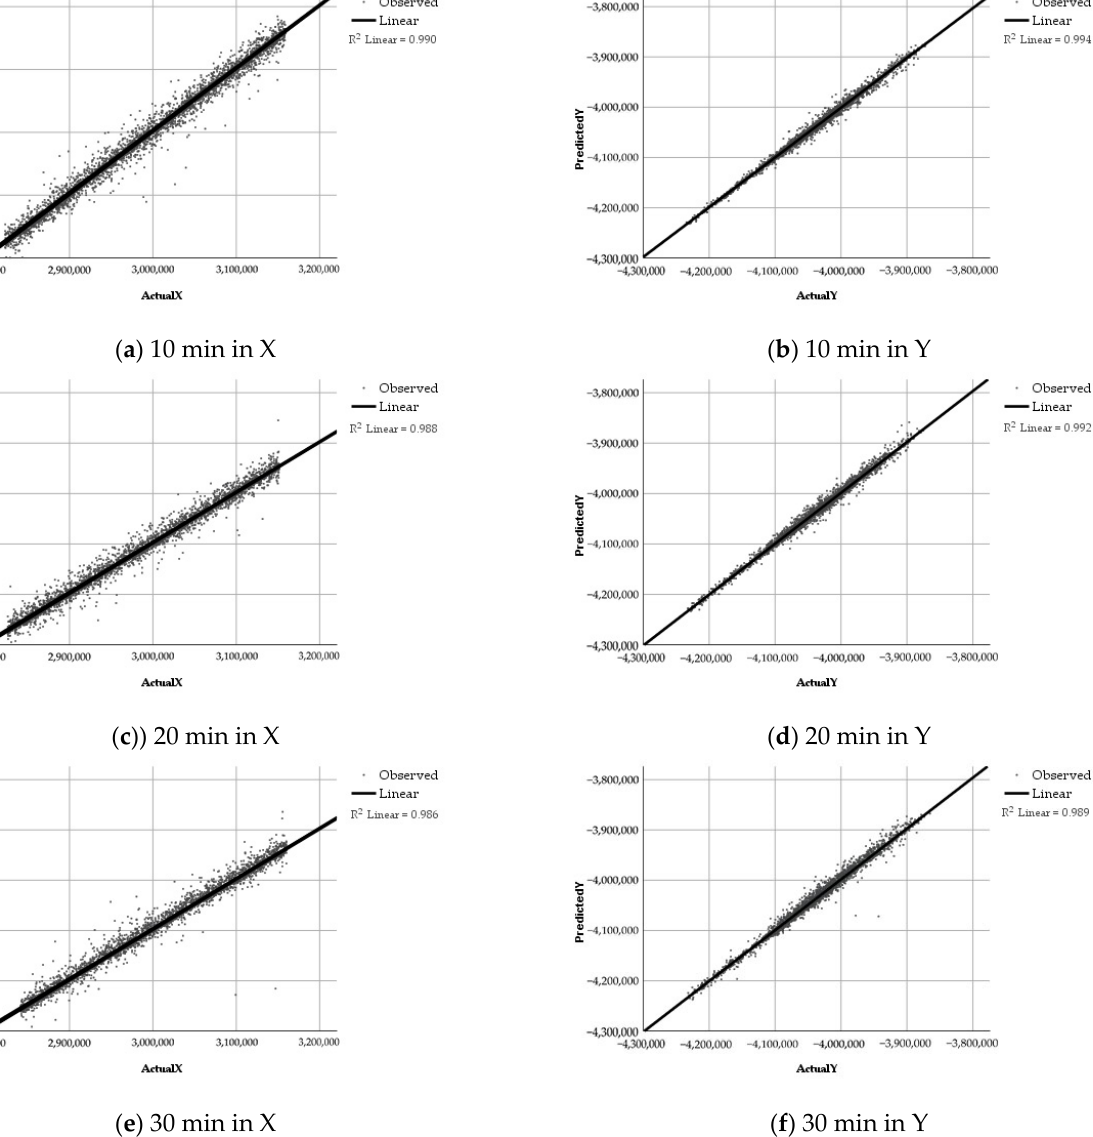
Figure 10. Scatter estimation plot between actual and predicted values ( a , b ) show the correlation of X and Y within 10 min; ( c , d ) show the correlation of X and Y within 20 min; and ( e , f ) show the correlation of X and Y within 30